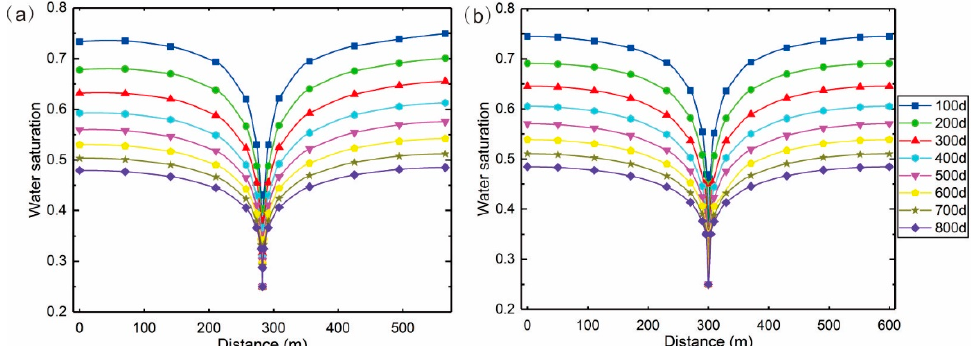
Figure 14. Distribution of the fluid saturation along the reference lines, ( a ) reference line AB (along the dip of the reservoir), ( b ) reference line CD (along the strike).